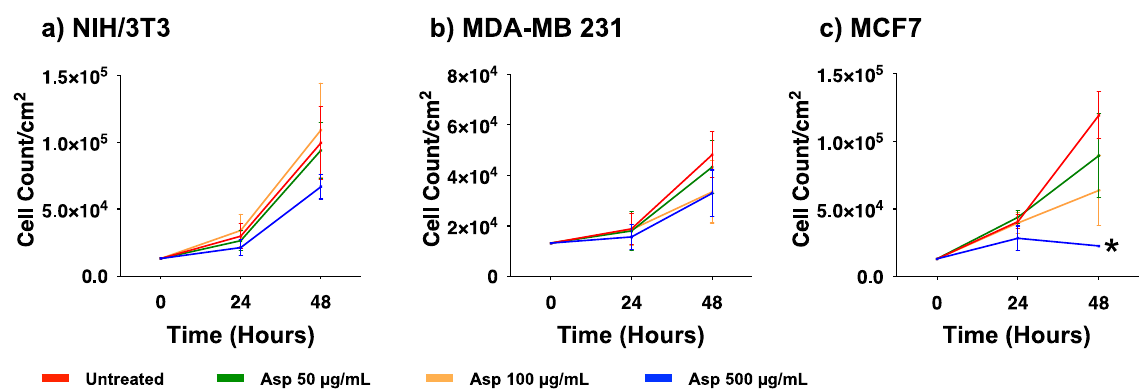
Figure 2. Cell viability of ( a ) NIH/3T3, ( b ) MDA-MB231, ( c ) MCF7 exposed to 50, 100, and 500 µ g/mL of Asp for 24 and 48 h. Data are reported as mean ± standard error of the mean from three independent experiments. Statistical analysis was performed by ANOVA followed by Bonferroni’s post hoc test. * p ≤ 0.05 vs. untreated at the same incubation time.